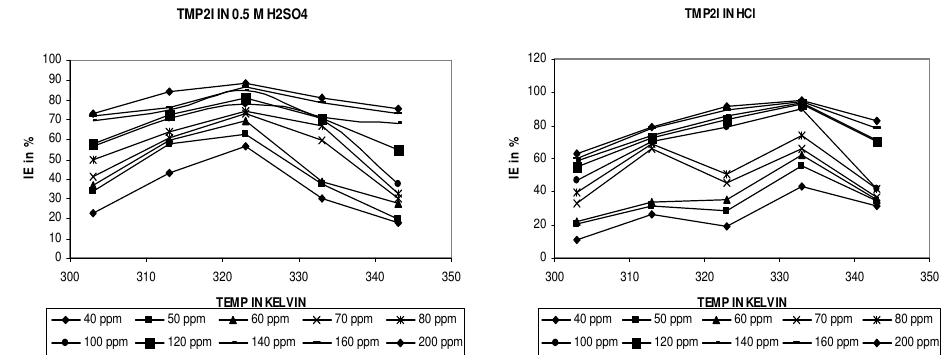
Figure 3. Effect of temperature on the inhibitor efficiency of TMP2I in acid